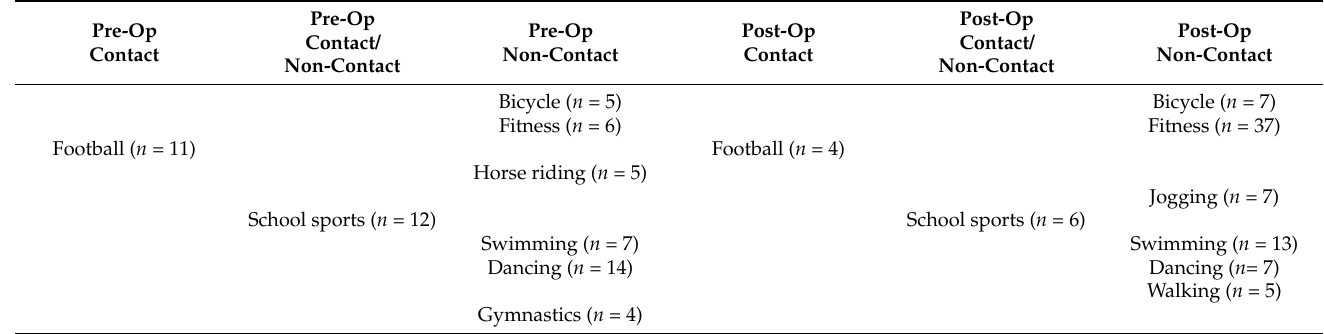
Table 1. Sport categories of the study cohort.